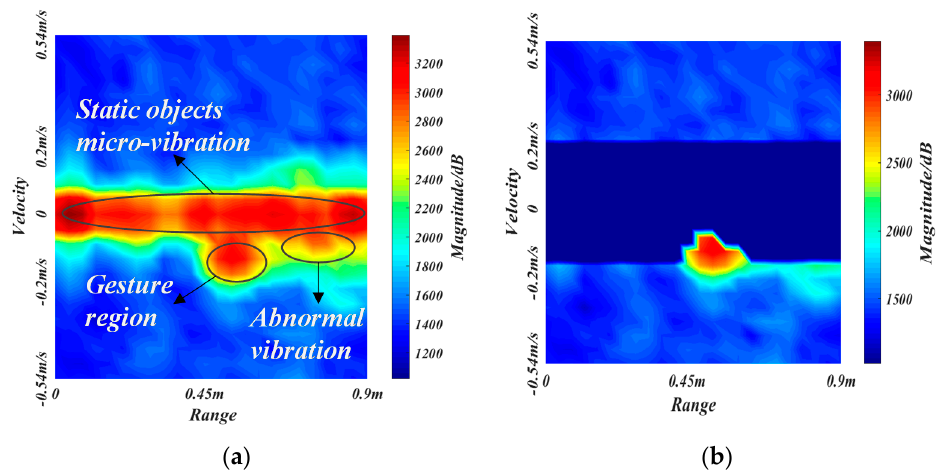
Figure 9. The results of the vibration removal algorithm. ( a , b ) are the figure before and after vibration removal, respec- tively.